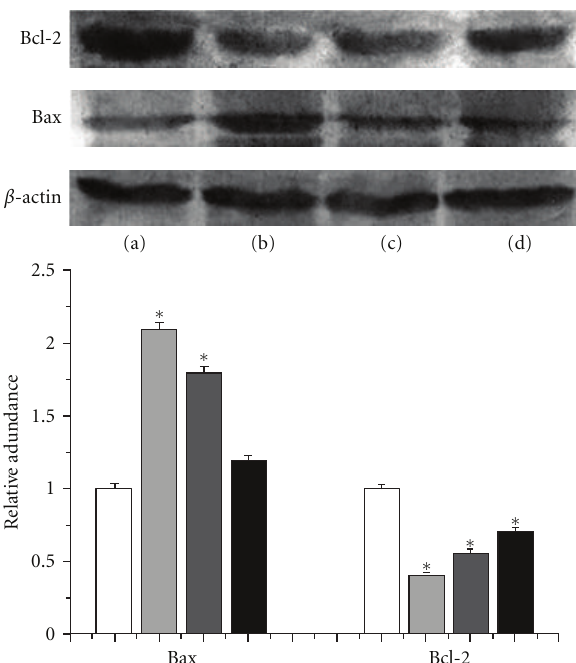
Figure 2: E ff ects of GCPs on the expressions of bcl-2 and bax pro- tein in HepG2 cells. Lane (a): control; Lane (b): 5-Fu (1.3mg/mL); Lane (c): GCPs (1.6mg/mL); Lane (d): GCPs (0.8mg/mL). ∗ P < 0 . 05 versus Control.